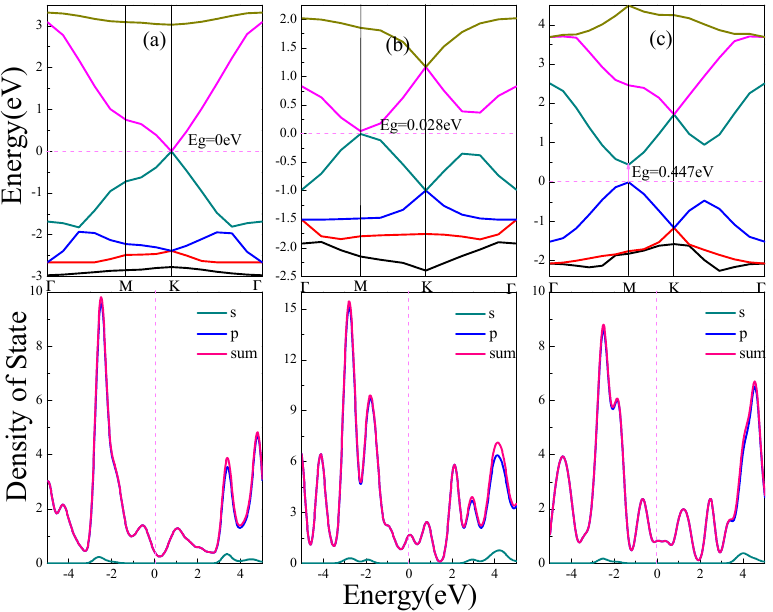
Figure 2. Energy band and density of states of graphynes ( α , β , γ ). ( a ) α -graphyne. ( b ) β -graphyne. ( c ) γ -graphyne. In this picture, Eg indicates the band gap. The letters s and p represent partial density of states of s orbital and p orbital of C atoms respectively, and sum represents total density of states. As shown in Figure 2a for the case of α -graphyne, the conduction band minimum and valence band maximum coincide at one point on the Fermi level, which is the K point in Brillouin zone; On both sides of the Fermi level, the band gap diverges from the K point to form two symmetric Dirac cones, which has zero curvature at least in one direction. The α -graphyne has a zero band gap and DOS approaches zero at Fermi level. For β -graphyne and γ -graphyne, the energy band forms Dirac zone at point M in Brillouin zone, and direct band gaps of 0.028 eV and 0.447 eV are shown in Figure 2b,c respectively.